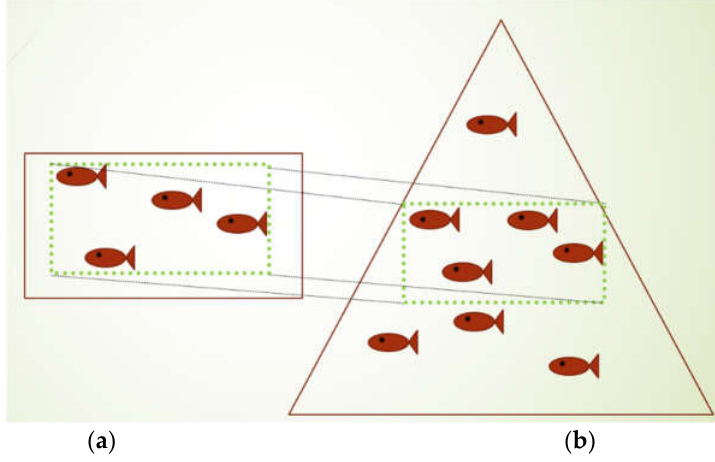
Figure 11. Schematic diagram of overlapping area detection.